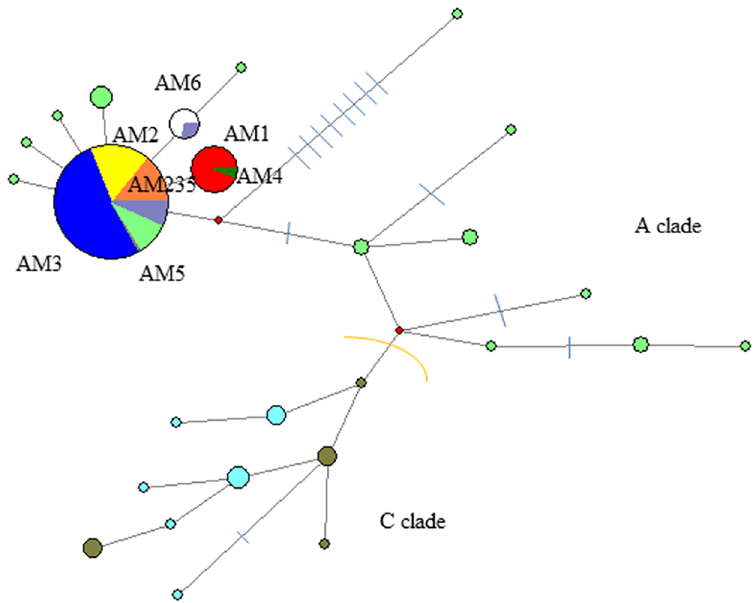
Fig 3. Median joining network of combined cyt b and d-loop sequences (256 bp) showing lineage affiliations of ancient and modern red deer from the Vosges compared to published ancient and modern sequences from the European range of red deer. The networks includes ancient red deer (haplotypes of the A clade from the Vosges (AM235 = orange; AM6 = white), modern red deer from the Vosges (red = AM1, yellow = AM2, dark blue = AM3, green = AM4, grey = AM5), published western-central European ancient and modern haplotypes from the A and C clades (modern A clade = grey blue, modern C clade = olive, ancient A clade = light green, ancient C clade = light blue; data from [10]. The size of the circles are proportional to the number of individuals, dashes indicate mutational steps.